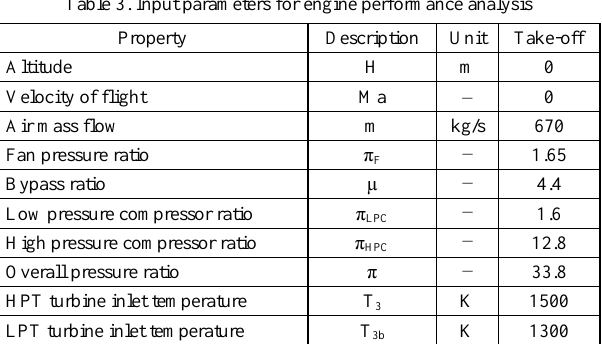
Table 3. Input parameters for engine performance analysis